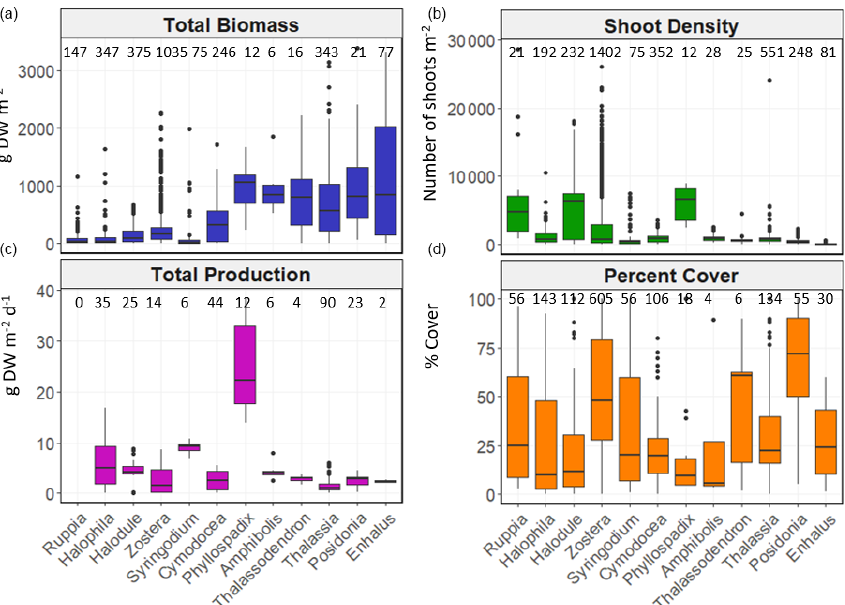
Figure 6. Box-and-whisker plots depicting total biomass (gDWm − 2 ), shoot density (number of shoots m − 2 ), total net primary production (gDWm − 2 d − 1 ) and percent cover (%) values per genera. The box plots show the median value (black line within box), 75% and 25% percentiles create the top and bottom of the box, and the tails are the maximum and minimum contributions within 1.5 interquartile range. Count of data ( N ) per bioregion is shown at the top of each